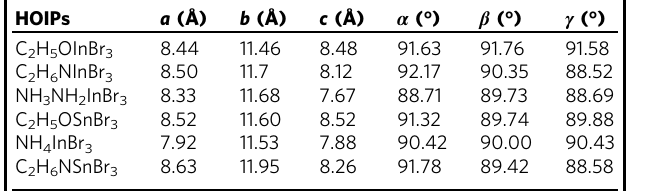
Table 1 Lattice constants of six selected HOIPs